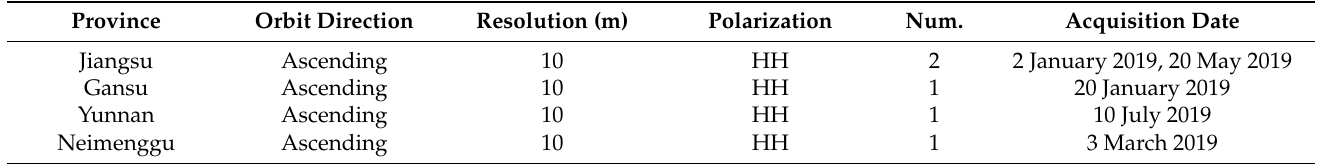
Table 2. Basic information of the GF-3 SAR data.